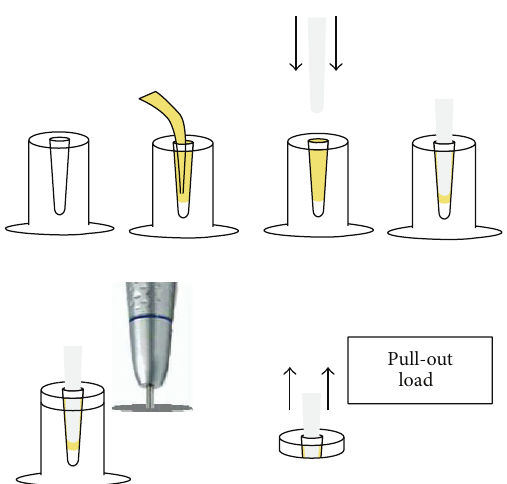
Figure 1: Schematic drawing of preparation of specimens for pull- out test.